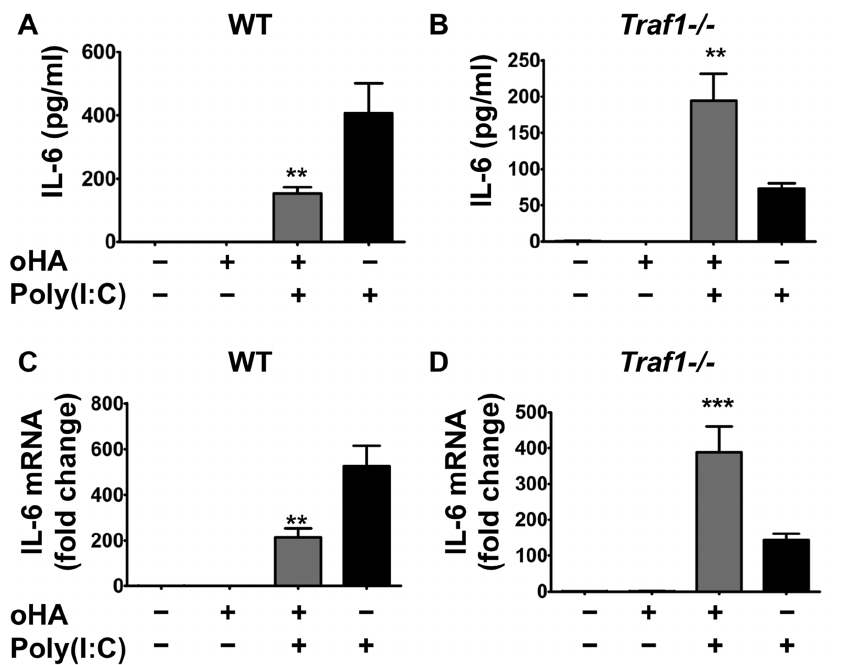
Figure 5. TRAF1 is necessary for oligo-HA to suppress IL-6 secretion and mRNA expression in peritoneal macrophages. Peritoneal macrophages from WT (A, C) and Traf1 2 / 2 mice (B, D) were treated with oligo-HA and/or poly(I:C) for 24 h. IL-6 release in cultured media was measured by ELISA (A, B). mRNA abundance for IL-6 was assessed by quantitative RT-PCR 4 h after treatment (C, D). Quantitative RT-PCR data are presented as normalized data against vehicle-treated macrophages. Data are presented as means 6 S.E.M. and are representative of three